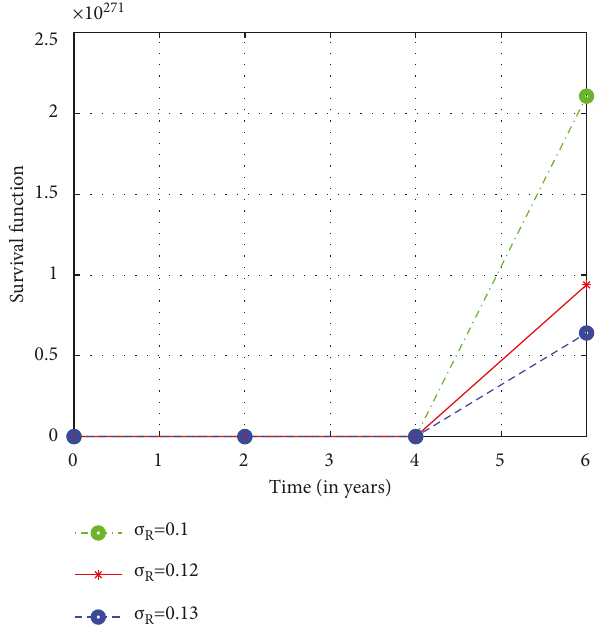
Figure 3: Dependence of the survival function on the return